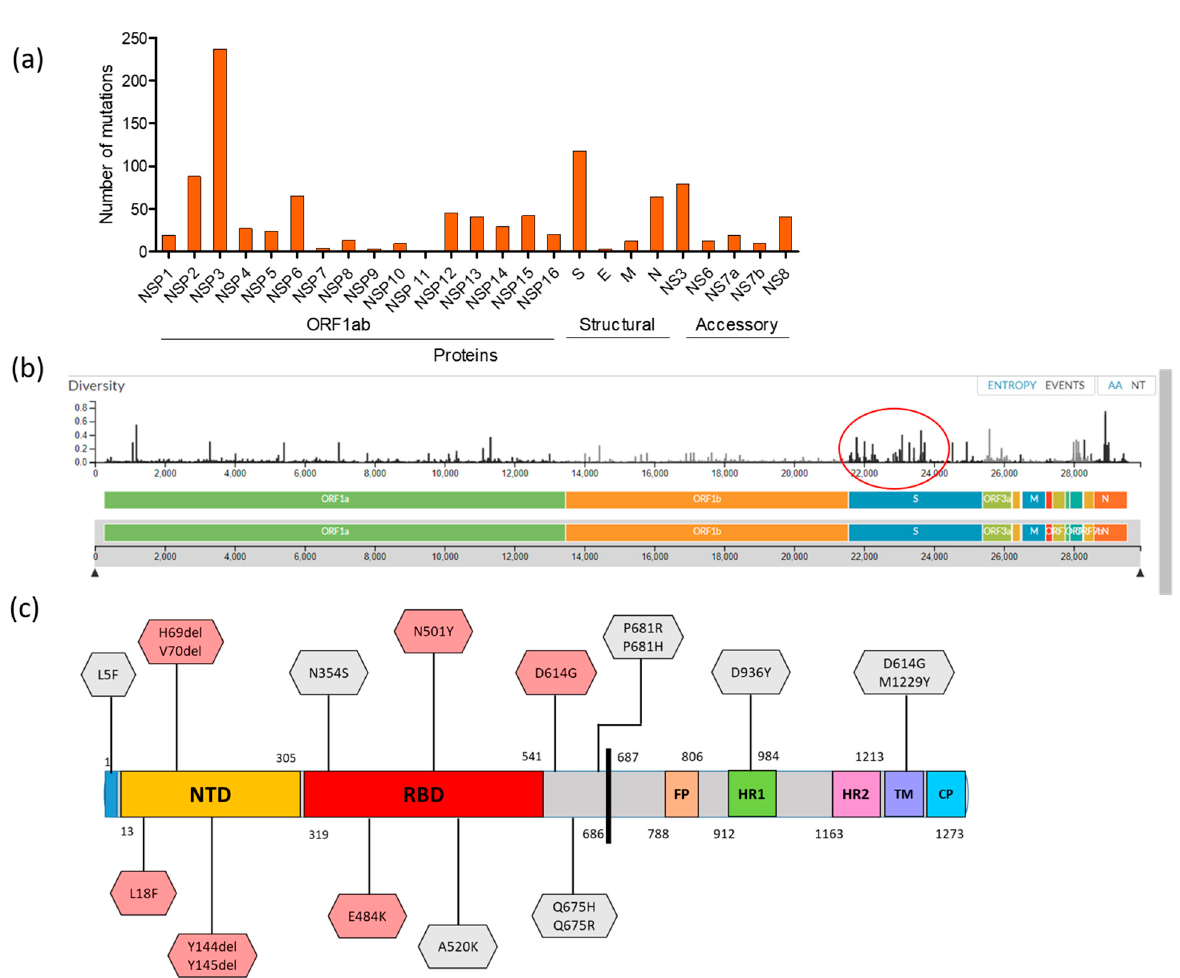
Figure 5. Mutational profile of Bangladeshi SARS-CoV-2. ( a ) Graph showing the total number of mutations detected by each encoded protein. ( b ) Nextstrain generated amino acid (AA) diversity graph of respective proteins; the spike protein had the most diversity (red circled). Diversity scale ranges from 0.0 to 0.8 are shown on the left side of the graph. ( c ) Illustration of selected amino acid substitutions in the S protein that are responsible for increased infectivity. The reddish substitutions are globally established, naturally occurring variants that increase infectivity, whereas the gray substitutions are found to be infective in experimental infection [8] .